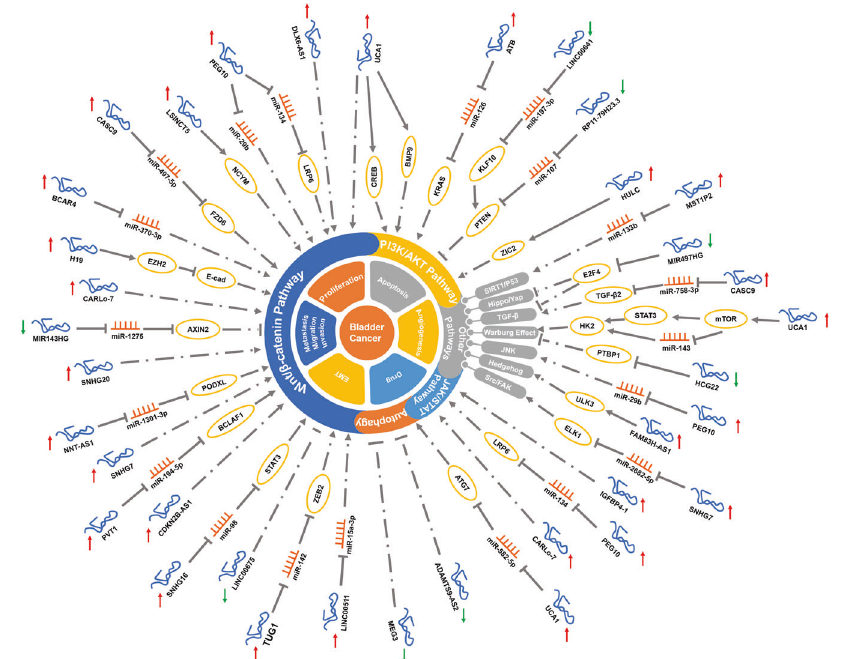
Fig. 2 The detailed mechanisms of lncRNAs on tumor classic pathways in